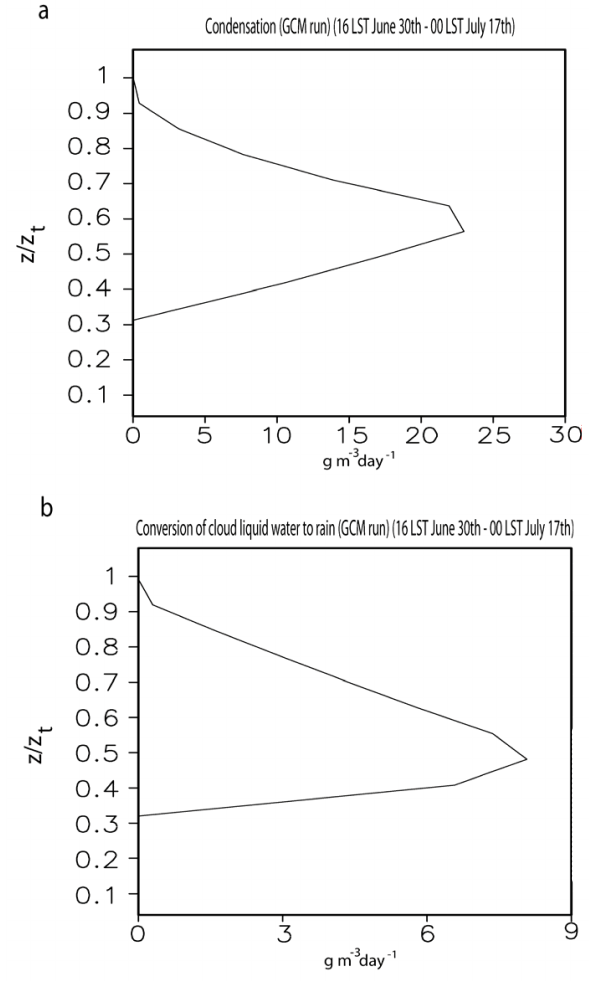
Fig. 20. Vertical distribution of the time- and area-averaged (a) condensation and (b) conversion of cloud liquid water to rain (gm − 3 day − 1 ) over 16:00LST 30 June–00:00LST 17 July for the GCM